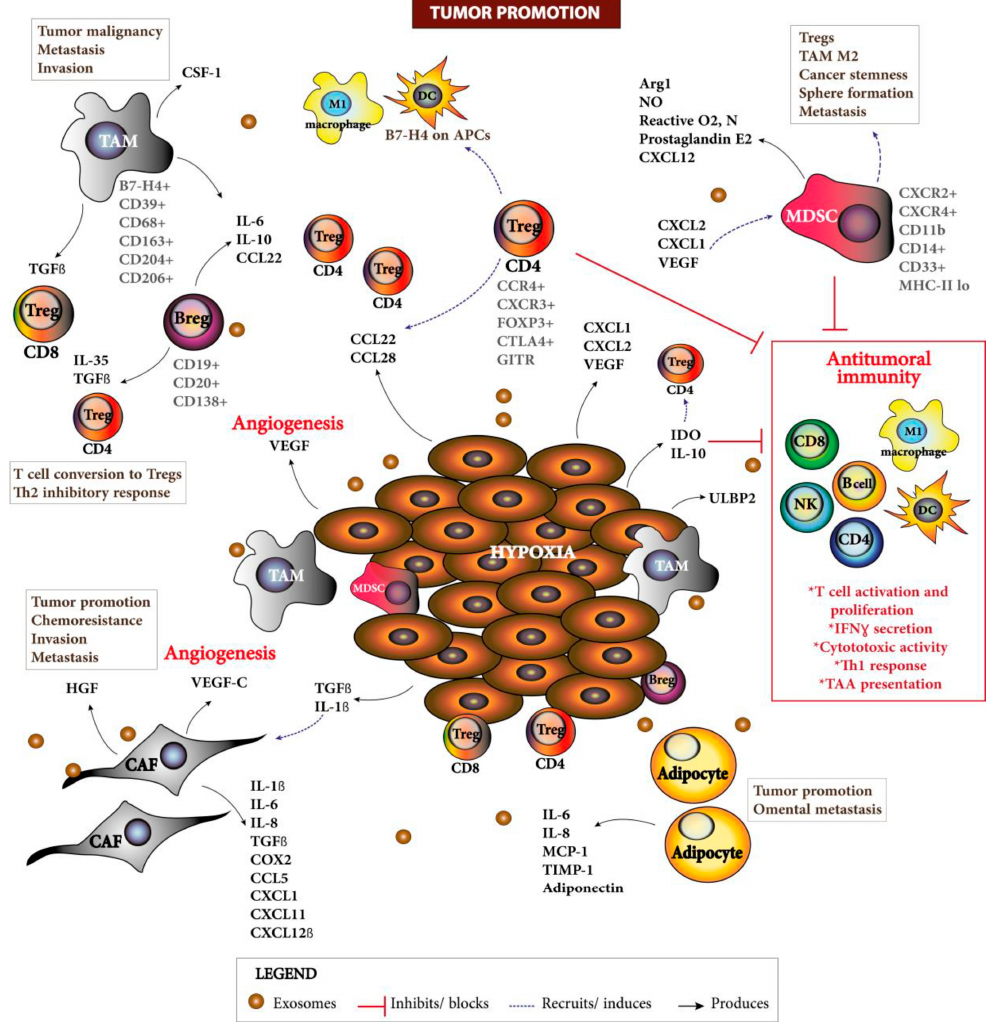
Figure 2. Tumor promoting network in the EOC TME. Outgrowth of EOC provokes hypoxia